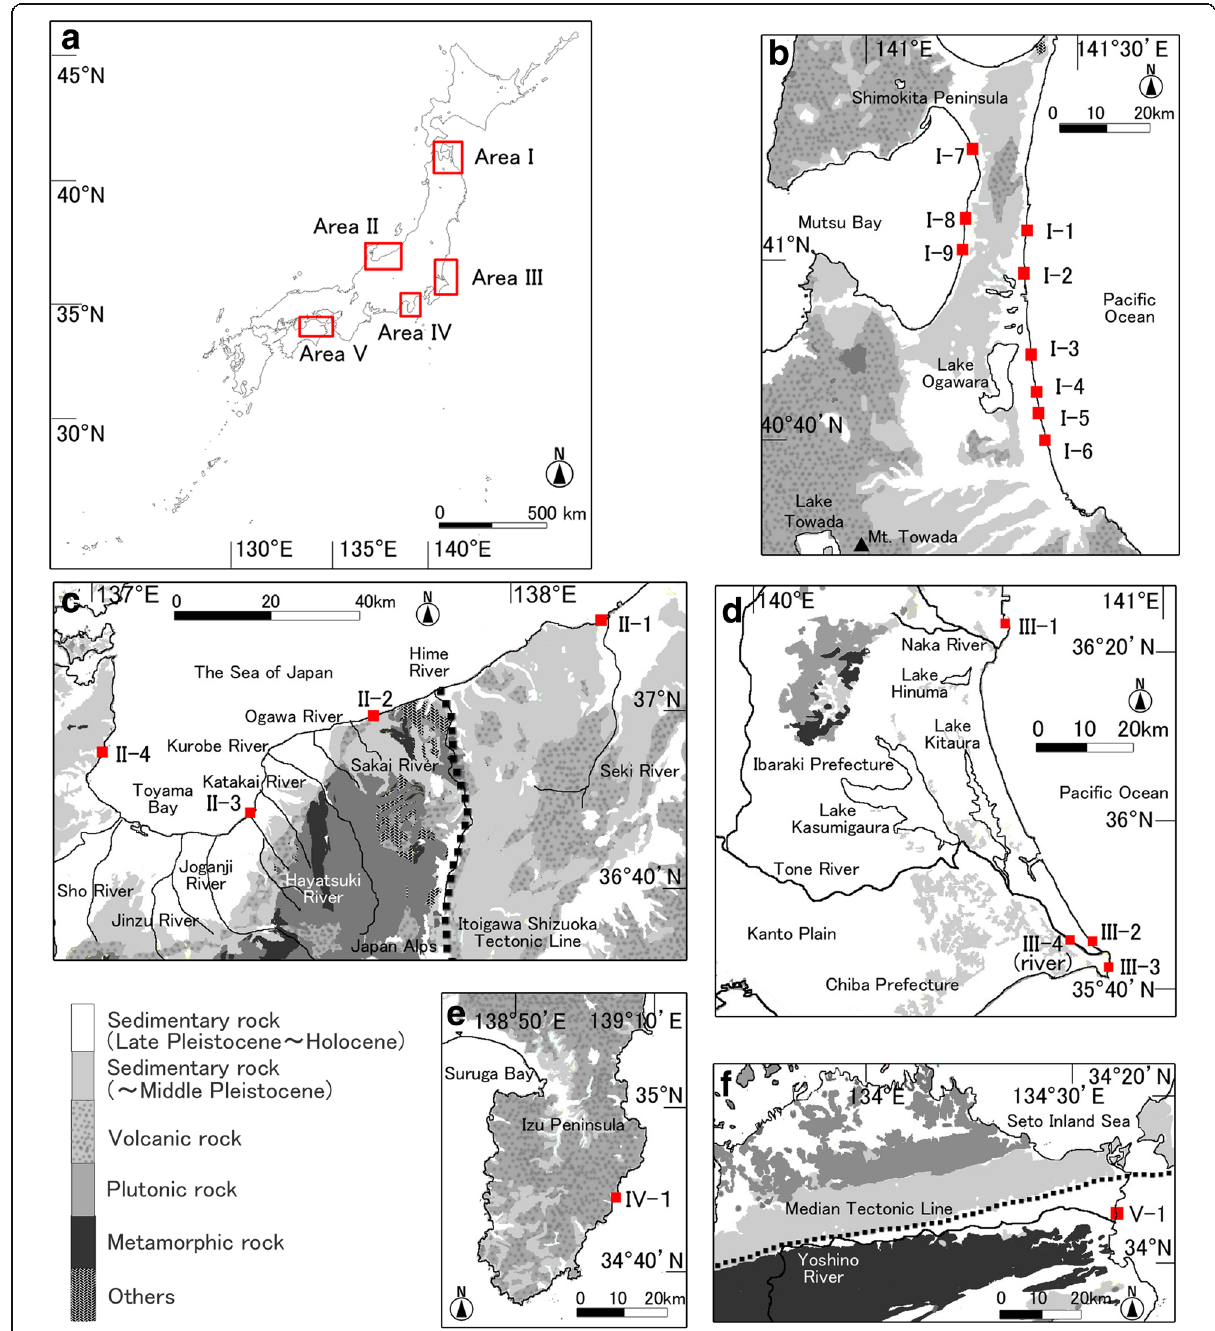
Fig. 1 Map legends correspond to b ~ f . a Map of the sampling areas in Japan. b Geological map of sampling area I. c Geological map